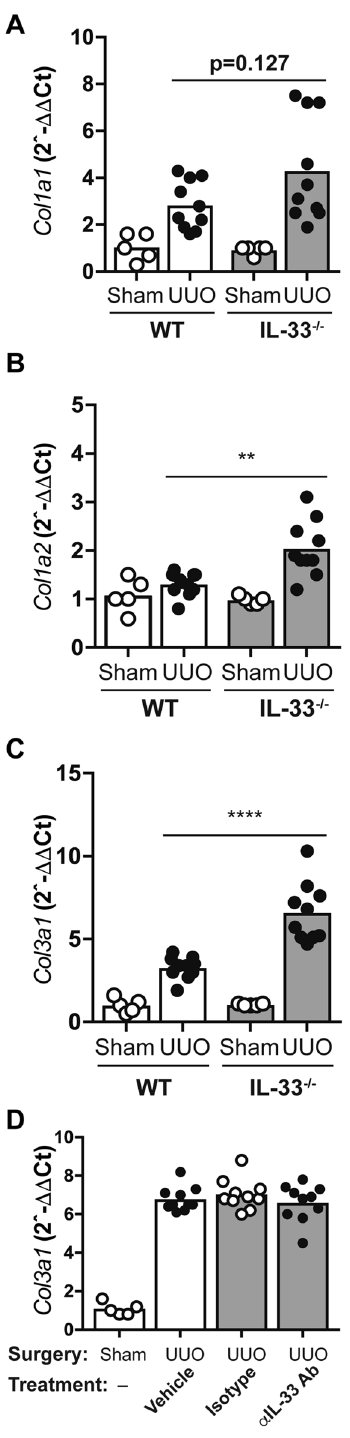
Figure 3. IL-33 attenuates the expression of collagens in the early phase of UUO. ( A – C ) Transcription of Col1a1 , Col1a2 , and Col3a1 in kidneys from IL-33 −/− and WT mice 1 day after sham-operation (n = 5 per genotype) or UUO (n = 10 per genotype). ( D ) Transcription of Col3a1 in kidneys from WT mice treated with anti-IL-33, isotype control antibodies or vehicle prior to UUO. Kidneys were harvested 24 h after UUO (n = 10 per treatment group) or sham-operation (n = 5). Transcription levels were quantified by qRT-PCR. Data points represent individual mice, bars show mean values. **p < 0.01, ***p <